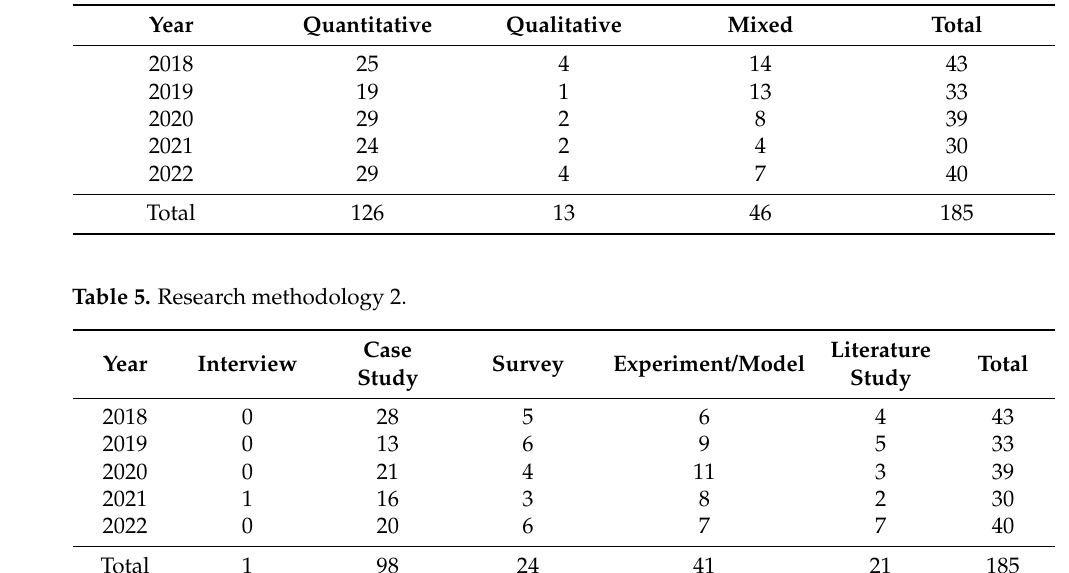
Table 4. Research methodology 1.